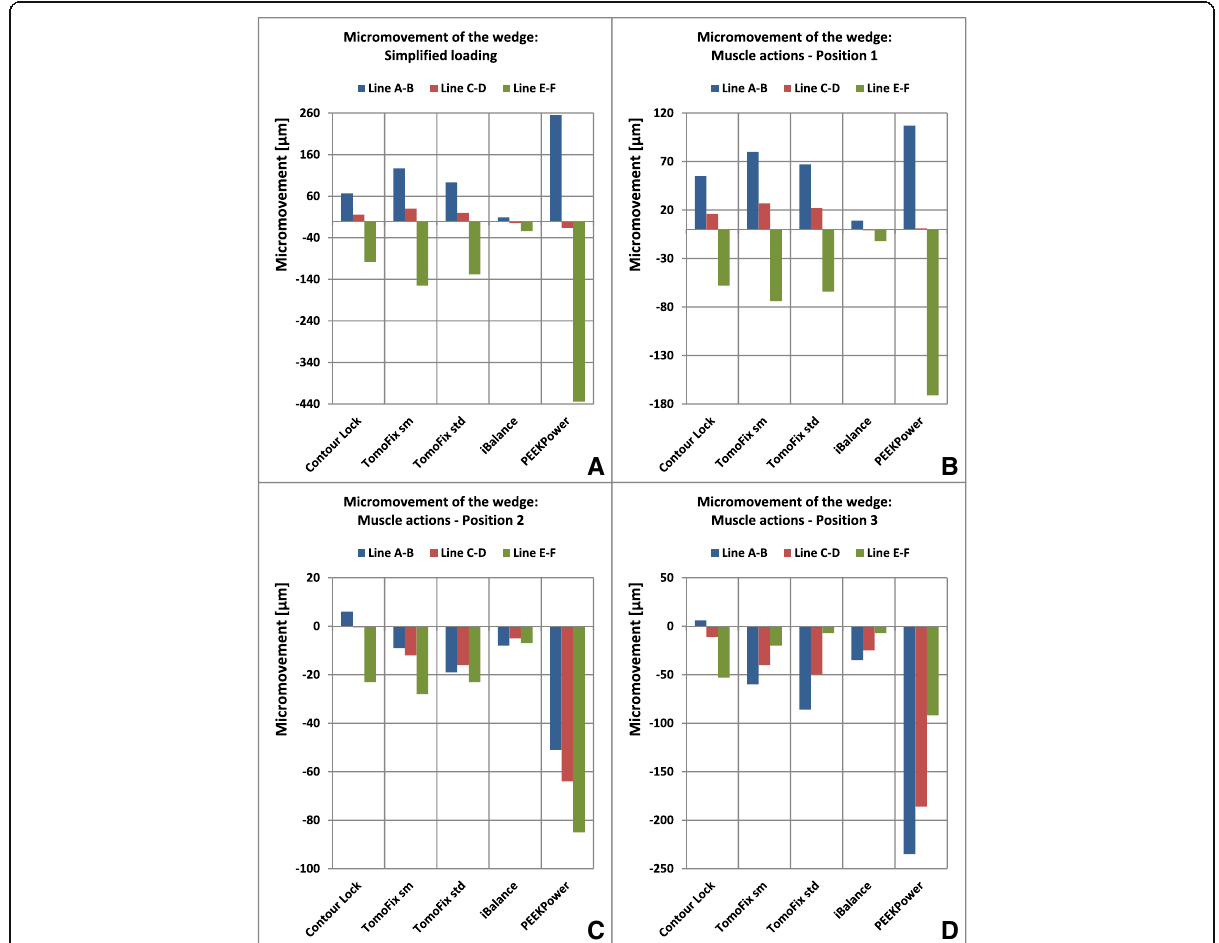
Fig. 11 Micromovements of the open wedge: The micromovements under the simplified loading and the muscle force loading in position 1 were